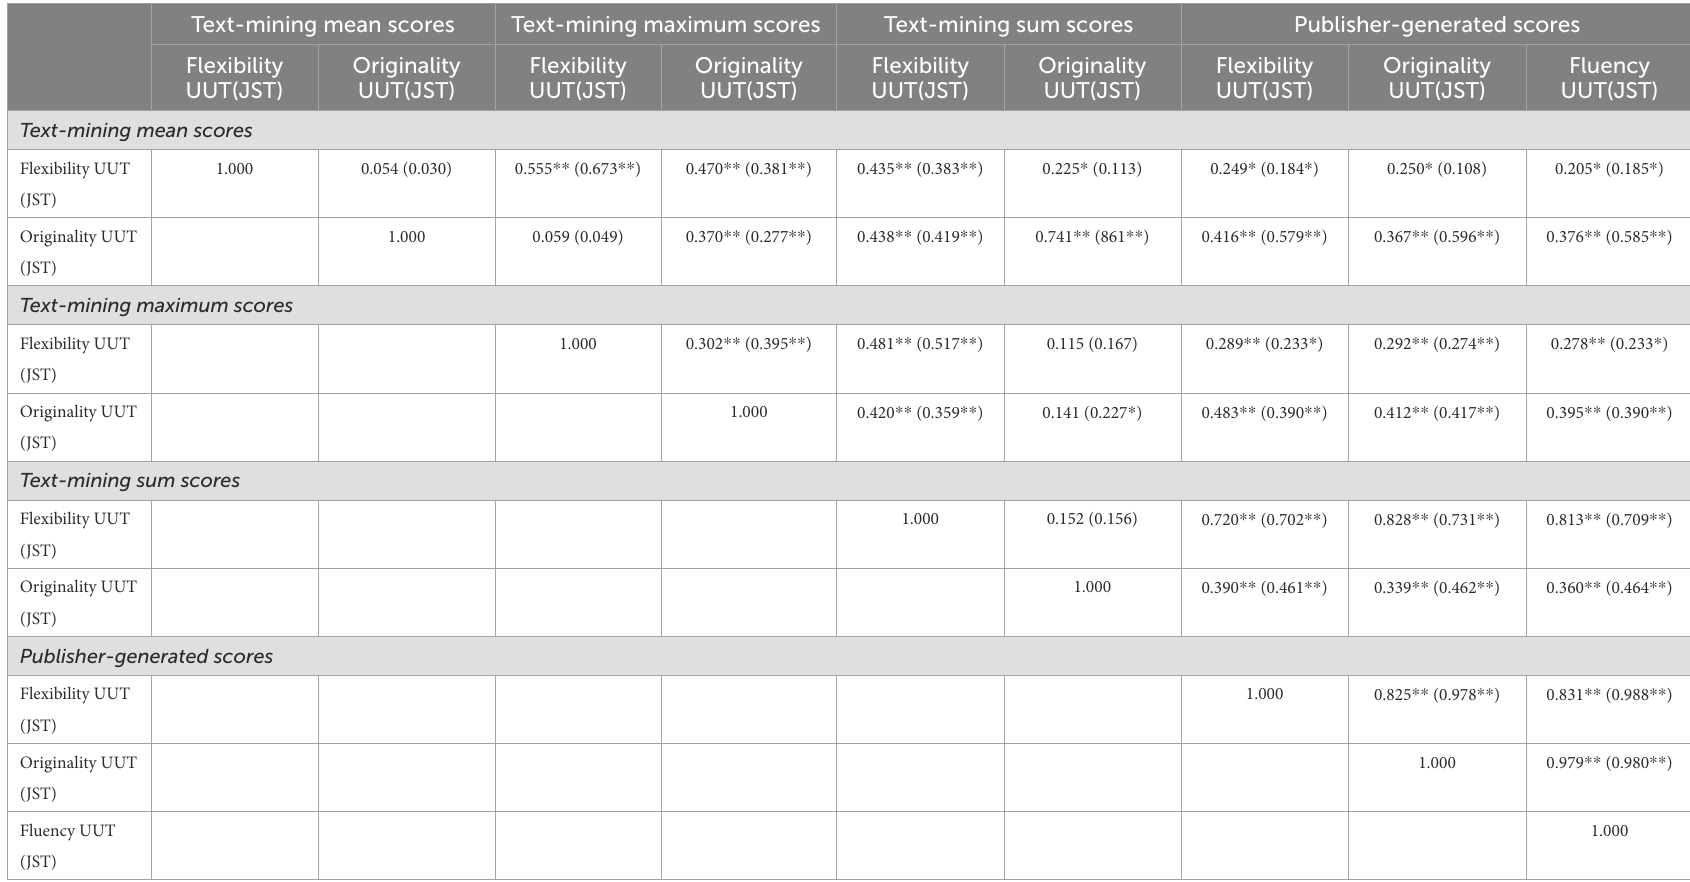
TABLE 3 Correlations of mean and maximum flexibility and originality scores with publisher-generated scores of the TTCT